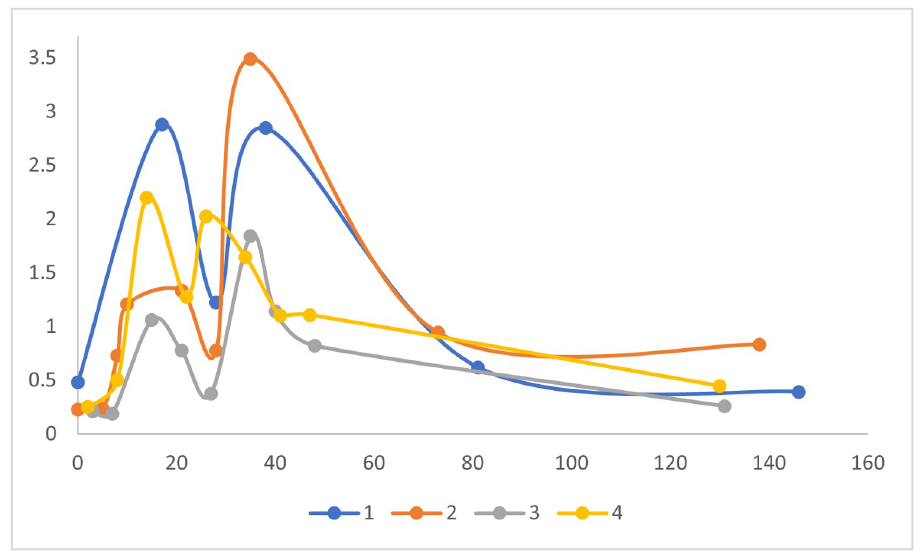
Fig 2. Time course of spike antigen-specific IgA response to COVID-19 mRNA vaccine. ELISAs were performed on serum from 4 subjects described in Table 1, at different time points after vaccination (X-axis, days). Serum IgA levels are proportional to ELISA optical density values (Y-axis). Each symbol represents average ELISA data for a single subject at a single time point. Scatter plots were fitted with a moving average trend line. Note 2 nd vaccine dose was at day 28 for subjects 1–3, and day 21 for subject